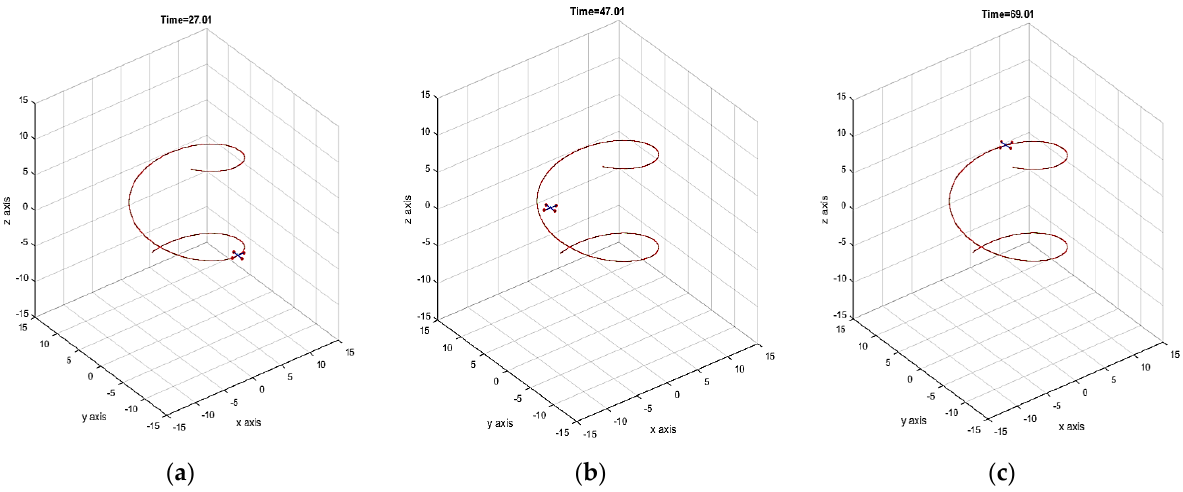
Figure 17. Quadrotor following helical trajectory using SDF-SMC (without model-free approach).